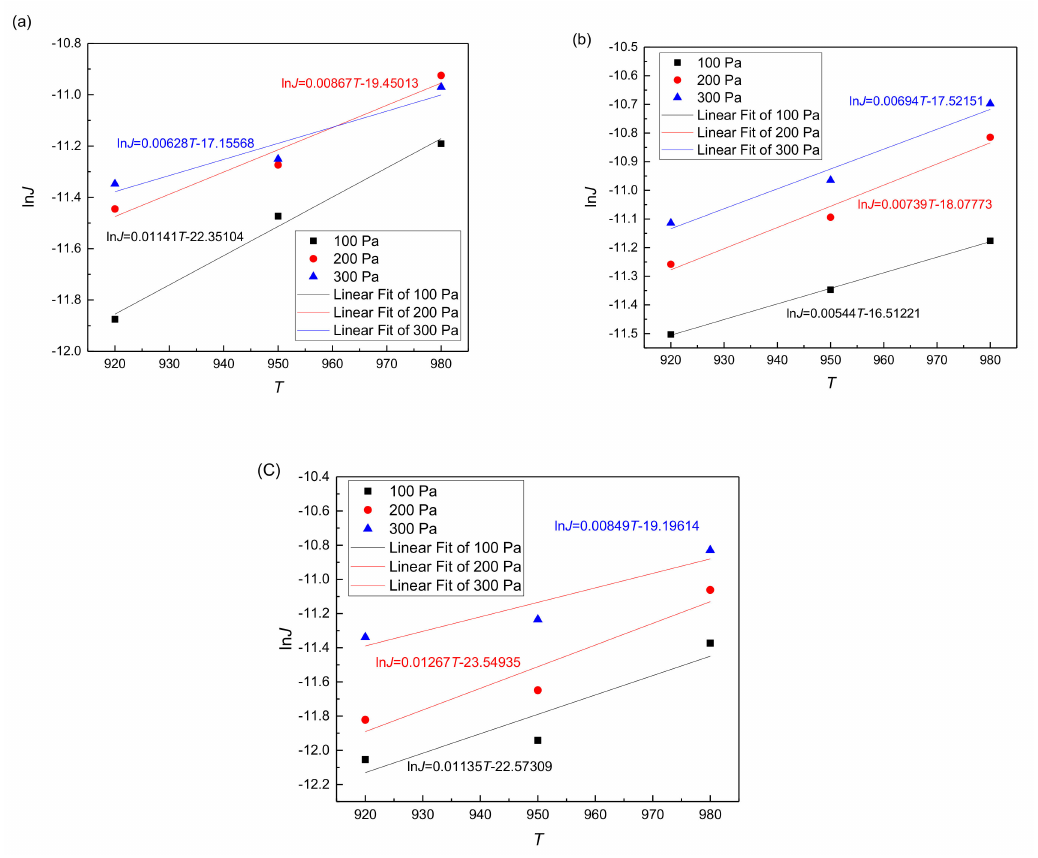
Figure 15. Regression curves of carburization temperature and ln J : ( a ) 12Cr2Ni4A steel, ( b ) 16Cr3NiW MoVNbE steel, and ( c ) 18Cr2Ni4WA